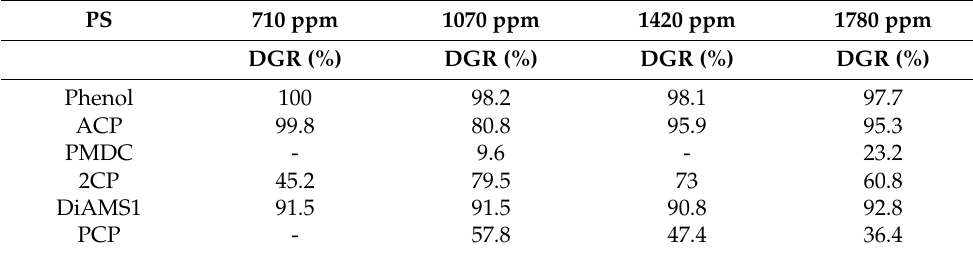
Table 4. Degradation rates of compounds in emulsions formed by bacterial cultures and different quantities of phenolic industrial by-product stream. The following data are given: concentrations of phenolic by-product stream added to the cultures (PS), expressed in ppm, and degradation rate (DGR, % of the initial concentration). The DGR was obtained for each phenolic compound based on its remaining content in the culture after 7 days. The content of each compound in the PS is given in Table 2. Each value corresponds to the average of three replicates. PS 710 ppm 1070 ppm 1420 ppm 1780